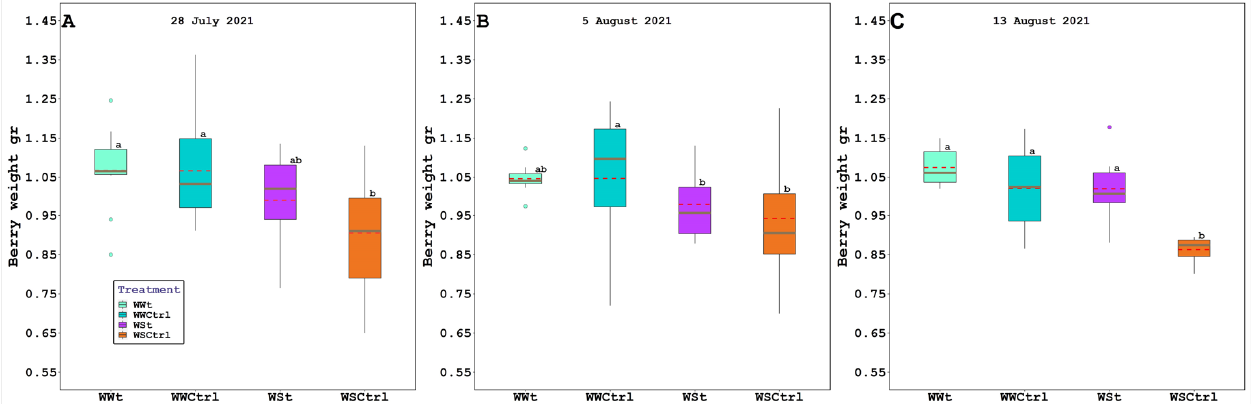
Figure 6. Berry weight (bw; gr) in Vitis vinifera (Pinot Noir cv.) treated with Zeolite (t) and untreated plants (Ctrl), under two irrigation regimes (WW, well-watered; WS, water-stressed); ( A ). 28 July 2021, ( B ). 5 August 2021, and ( C ). 13 August 2021. The box bounds show the 25 and 75 percentiles, and the error bars the 90 and 10 percentiles. The black continuous and red discontinuous lines inside the boxes represent medians and means, respectively. Outliers are represented as color dots. Average values with the same letter in each figure indicate no significant differences between plots ( p < 0.05). At harvest, the berry weight was − 19.62%, − 15.68%, and − 15.68% lower in WSCtrl than in WWt, WWCtrl, and WSt vines, respectively. Table 3. Two-way ANOVA ( p < 0.05) for technological parameters in Vitis vinifera (Pinot Noir cv.) treated with Zeolite (t) and untreated plants (Ctrl), under two irrigation regimes (WW, well-watered; WS, water-stressed). Values are the mean of the data of each parameter, considering treatments (zeolite and ctrl) and irrigation regime (Irrig. Regime) as factors. In the last 3 rows is indicated the significance. The same letter pictured on different treatments indicates no significant difference among them (mean ± SE, n = 10).